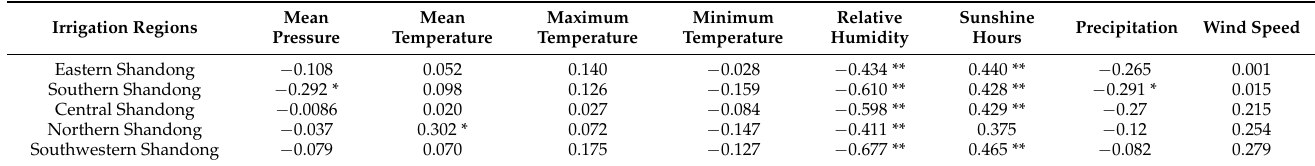
Table 6. Correlation coefficients and significance between irrigation water requirements of winter wheat and meteorological